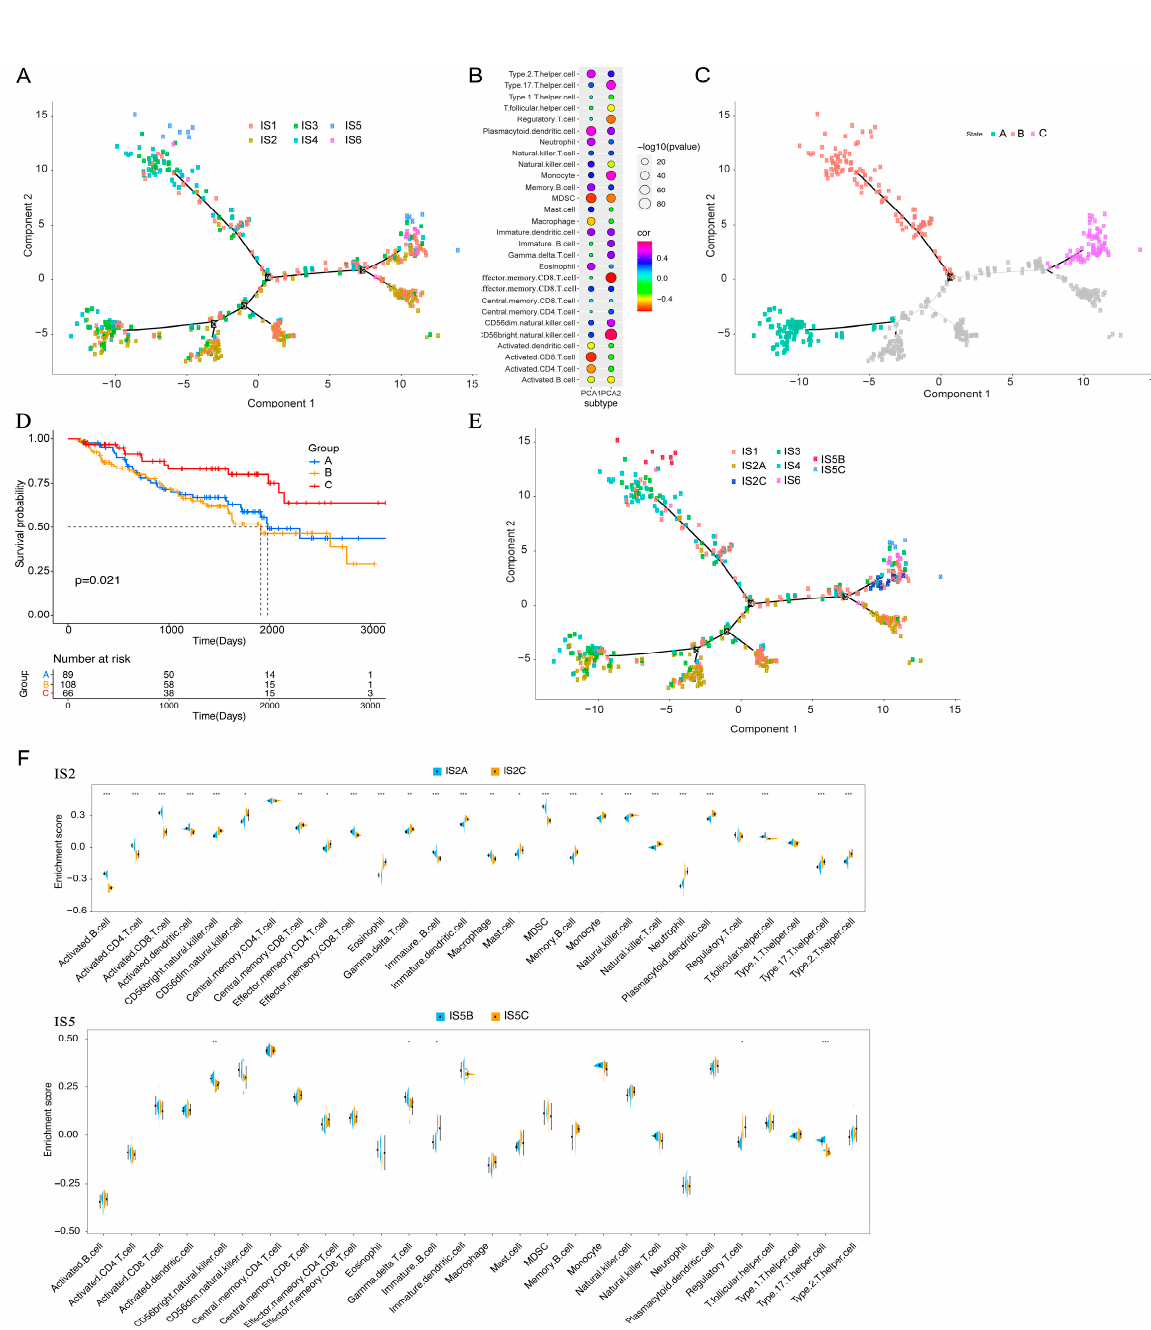
Figure 9. Immune landscape of KIRC. ( A ) Each dot represents a patient, and the immune subtypes are indicated in different colours. ( B ) Correlation between the principal component and immune cell infiltration. ( C ) Patients separated by the immune landscape based on their location. ( D ) Isolated patients have different prognoses. ( E ) Immune landscape of immune subgroups of IS2 and IS5 in KIRC. ( F ) Differential enrichment scores of 28 immune cell characteristics in the IS2 and IS5 subsets. Kidney renal clear cell carcinoma (KIRC); Immune subtype (IS). (* p < 0.05, ** p < 0.01, *** p < 0.001).